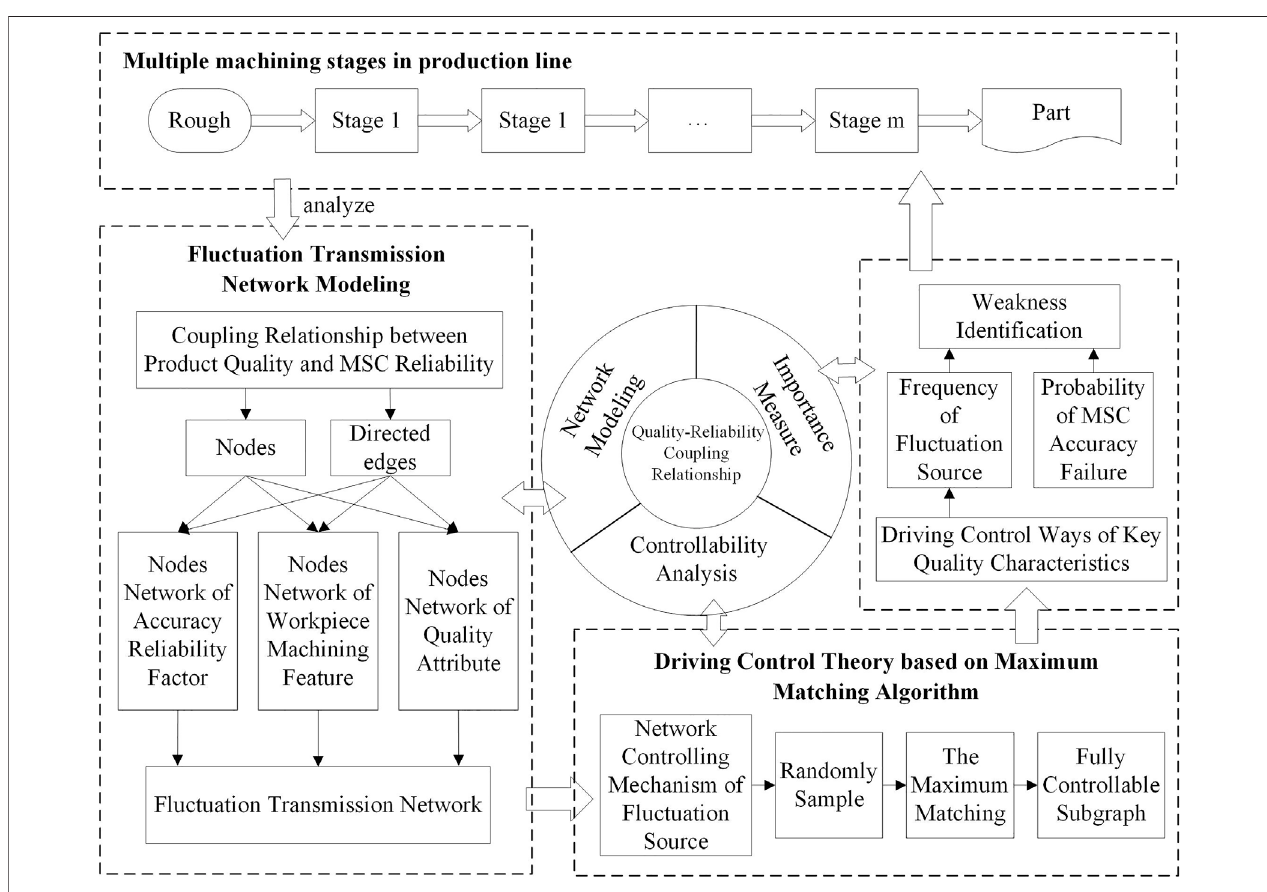
FIGURE 1 | Quality-reliability oriented system importance measure